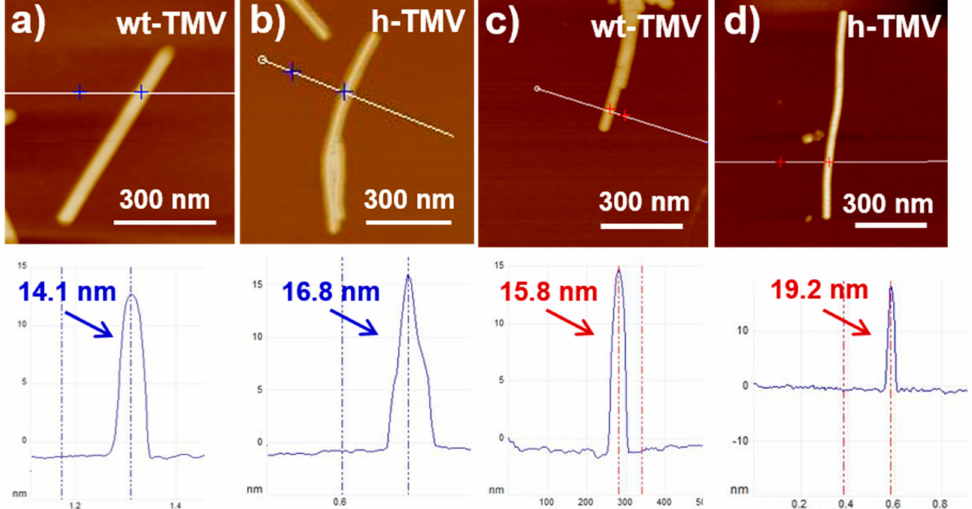
Figure 6. AFM height images with the corresponding cross-sections showing the virus height of: ( a ) wt-TMV and ( b ) h-TMV immobilized on hydrophilic (O 2 -plasma treated) silicon substrates. ( c ) wt-TMV